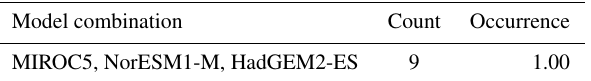
Table C5. Possible model combinations for the Greenland top three selection, with absolute and relative frequency of occurrence when applying the robustness test.